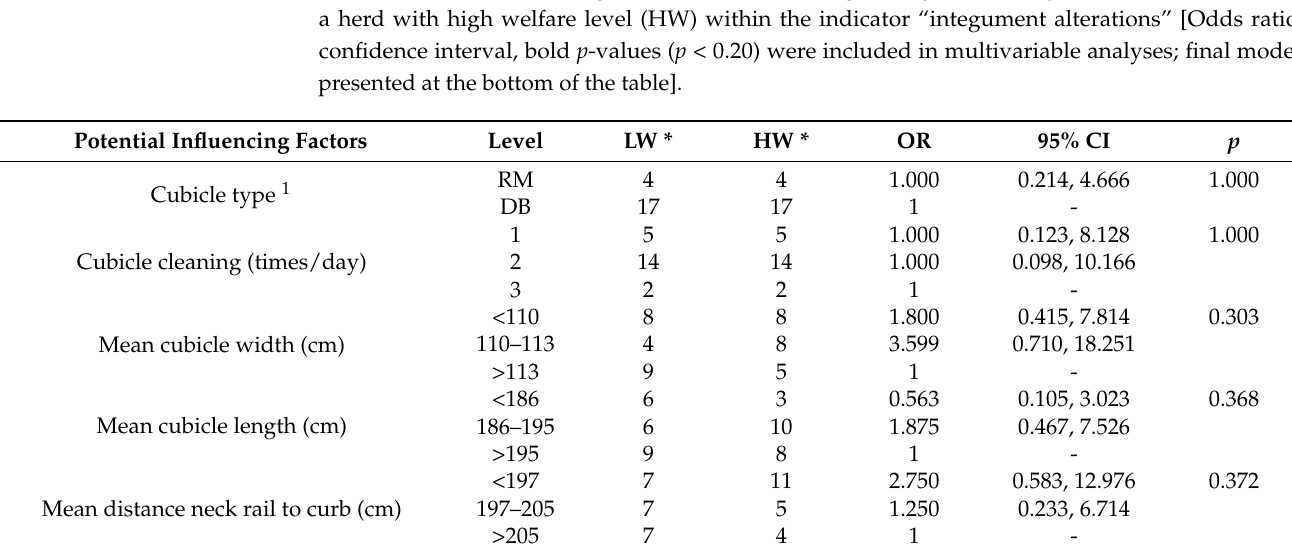
Table 5. Potential influencing factors in univariable logistic regression analysis associated with being a herd with high welfare level (HW) within the indicator “integument alterations” [Odds ratio, confidence interval, bold p -values ( p < 0.20) were included in multivariable analyses; final model presented at the bottom of the